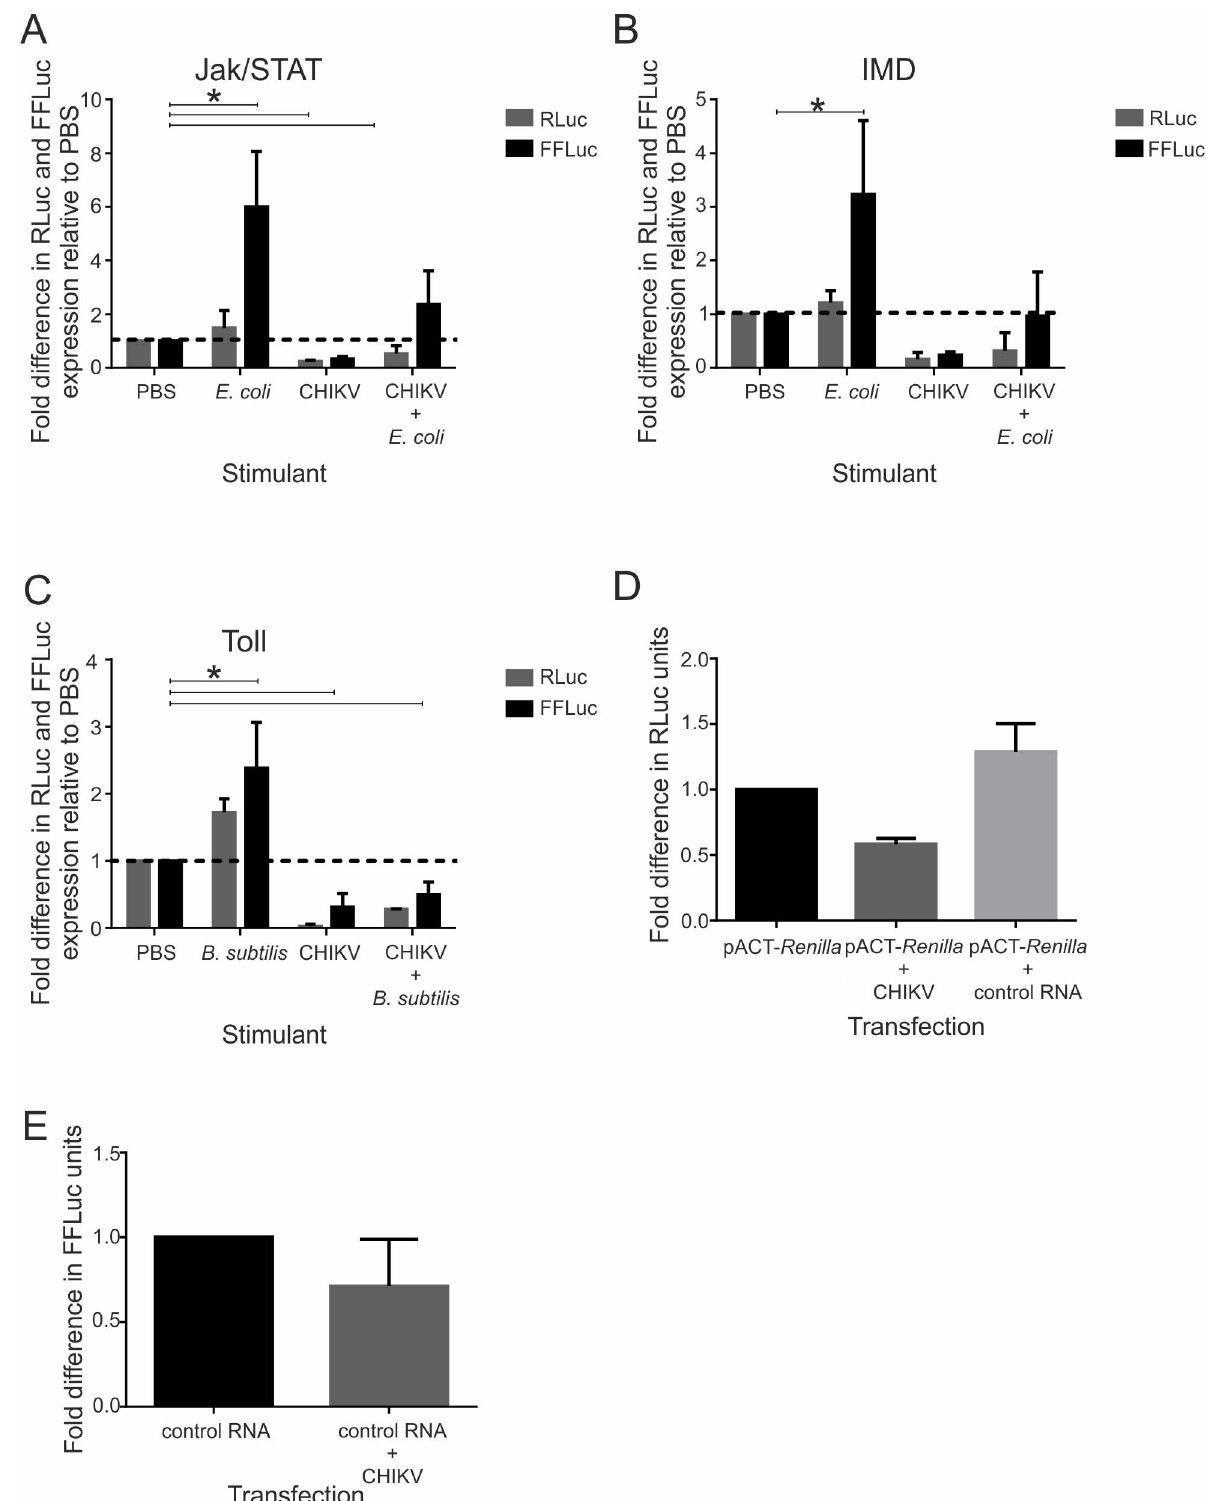
Figure 5. CHIKV inhibition of JAK/STAT, IMD and Toll signaling pathways. Signaling assays were performed as previously described [23]. Aag2 cells were co-transfected with reporter plasmids and in vitro transcribed CHIKVRep-SG-eGFP RNA, followed by stimulation of immune pathways by heat inactivated bacteria. Signaling activity was measured by activity of FFluc. Internal transfection control (RLuc) is shown to indicate the levels of gene expression. PBS, PBS added to cells containing only the pathway reporter and internal transfection control; E. coli , heat inactivated bacteria added to cells containing only the pathway reporter and internal transfection control; B. subtilis , heat inactivated bacteria added to cells containing only the pathway reporter and internal transfection control; CHIKV, PBS added to cells containing pathway reporter, internal transfection control and